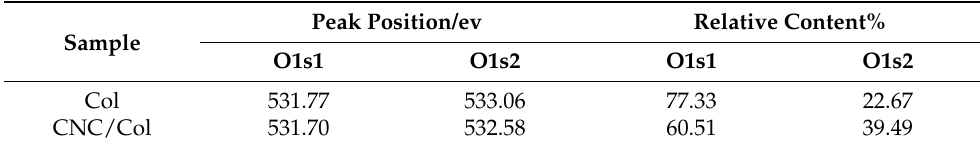
Table 1. High resolution O 1s XPS data of Col and CNC/Col.